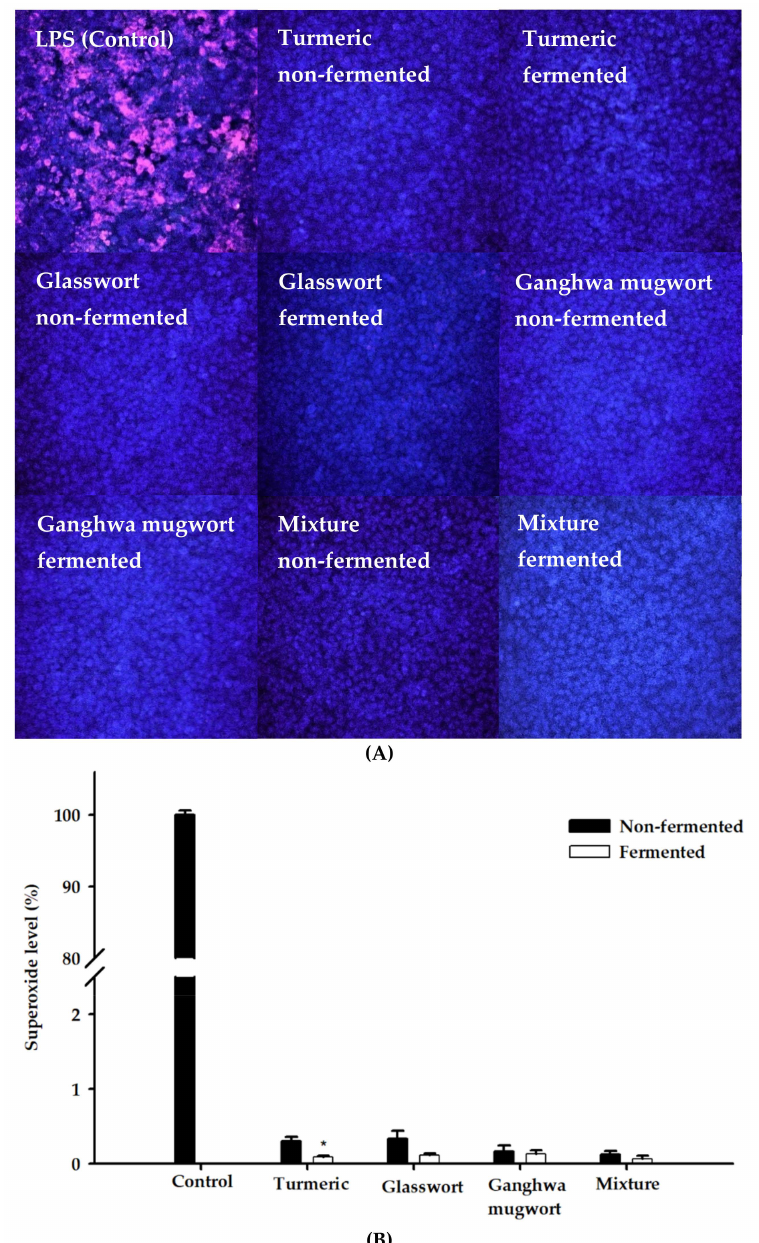
Figure 3. Antioxidant e ff ects of fermented and non-fermented medicinal plants in Bovine mammary epithelial (MAC-T) cells. ( A ) Fluorescence microscopic image of lipopolysaccharide (LPS)-treated MAC-T cells. MAC-T cells were pre-treated with 50 µ L / mL of fermented and non-fermented samples and DMSO (control) for 12 h, followed by exposure to LPS (1 µ g / mL) for 4 h. Then, the cells were stained with dihydroethidium (DHE; superoxide probe) and mounted on cover slips with an antifade mountant containing DAPI to detect intracellular superoxide production. The cells were visualized with a fluorescence microscope. ( B ) Intracellular superoxide level as quantified by the fluorescence intensity and expressed as a percentage of control. Samples were non-fermented and 16-h-fermented turmeric (5%, w / v ), glasswort (2.5%, w / v ), Ganghwa mugwort (2.5%, w / v ) and their mixture (1.66% ( w / v ) turmeric, 1.66% ( w / v ) glasswort and 1.66% ( w / v ) Ganghwa mugwort). * p <